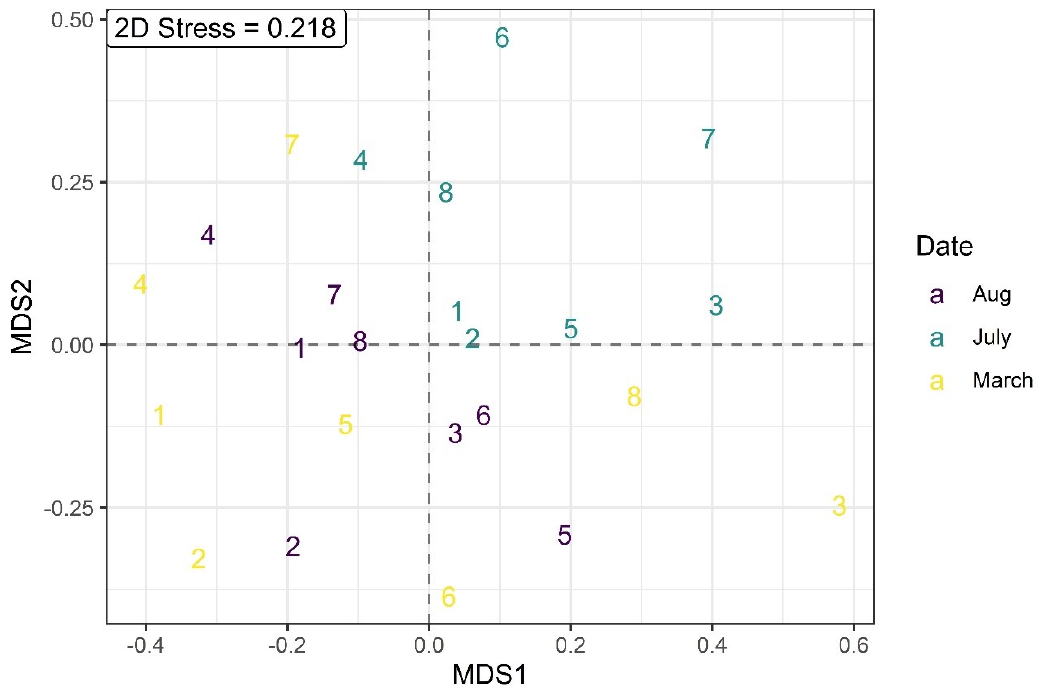
Figure 9. Non-metric multidimensional scaling ordination based on a matrix of abundance data for all taxa collected from 8 study sites in the Jeziorka River during three surveys.